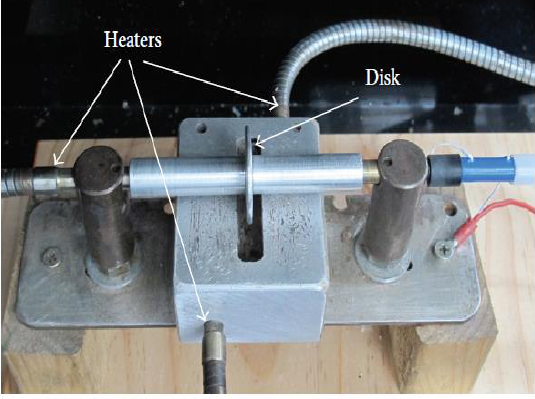
Figure 8. Needleless/disc melt electrospinning, where, the melt polymer is drawn out for the reservoir through the edge of the disc once it rotates (retrieved under the terms and conditions of the Creative Commons)